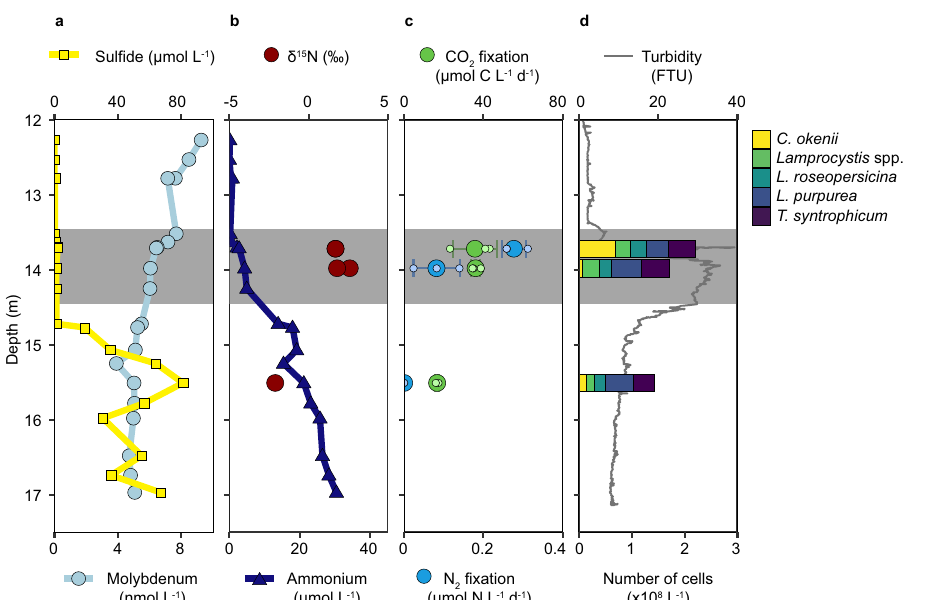
Fig. 1 Lake Cadagno chemocline nutrient, δ 15 N and turbidity depth pro fi le, bulk CO 2 and N 2 fi xation rates, and PSB abundance. a Molybdenum (light blue) and sul fi de (yellow) depth pro fi les. b Ammonium (dark blue) and δ 15 N values of bulk biomass (red circles, duplicate measurements at depths 13.7 m and 14 m, single measurement at 15.5 m). c Bulk N 2 fi xation rates (green) and bulk CO 2 fi xation rates (blue, determined in the same samples as N 2 fi xation rates). All rate measurements were performed in biological triplicates (except 15.5 m where one replicate was lost), individual replicates are shown as small circles, and the average rate is shown in large circles with the respective standard deviation. N 2 fi xation rates at 15.5 m depth were below the detection limit. d Abundances of key PSB populations (stacked bars, cell numbers based on FISH counts) and turbidity (gray line, a measure of total cell abundance). The location of the chemocline, as determined from the conductivity pro fi le, is indicated by gray shading ( a – d